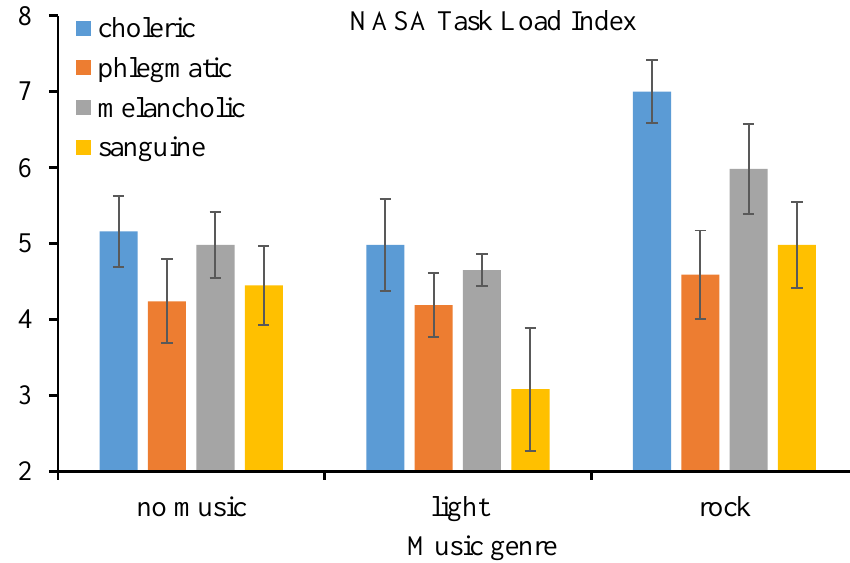
Figure 4. Perceived mental workload (and standard error) by music genre and personality.